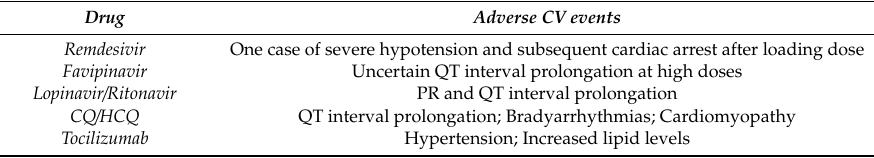
Table 2. Adverse cardiovascular events with COVID-19 experimental therapies. Drug Adverse CV events Remdesivir One case of severe hypotension and subsequent cardiac arrest after loading dose Favipinavir Uncertain QT interval prolongation at high doses Lopinavir / Ritonavir PR and QT interval prolongation CQ / HCQ QT interval prolongation; Bradyarrhythmias; Cardiomyopathy